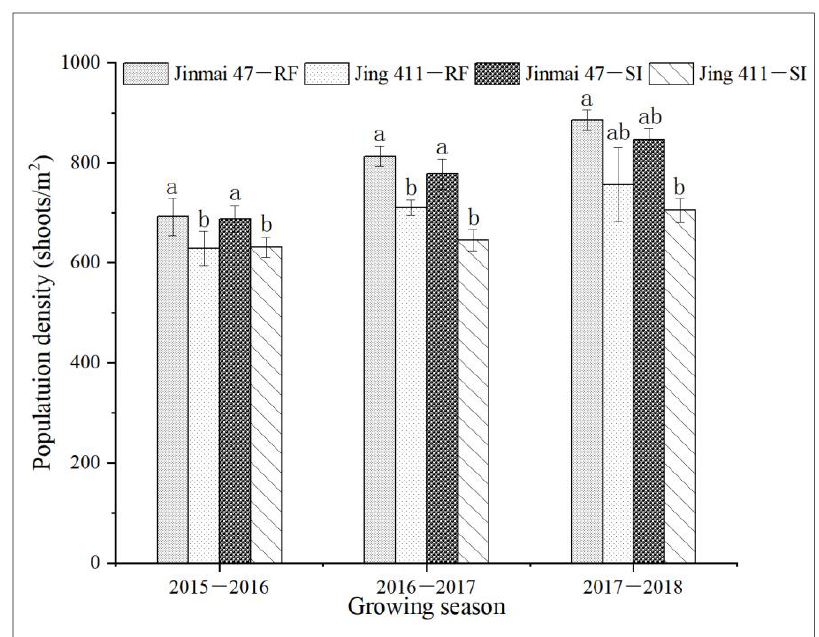
Figure 1. Population density (shoots/m 2 ) of the genotypes Jinmai 47 and Jing 411 under the rain-fed (RF) and supplemental irrigation (SI) conditions. For each growing season, the columns with the different letters differ significantly according to the least significant difference (LSD) test ( p < 0.05). Vertical bars indicate the standard deviation. Table 4. Canopy temperature depression (CTD, °C) of the genotypes Jinmai 47 and Jing 411 under the rain-fed (RF) and supplemental irrigation (SI) conditions.